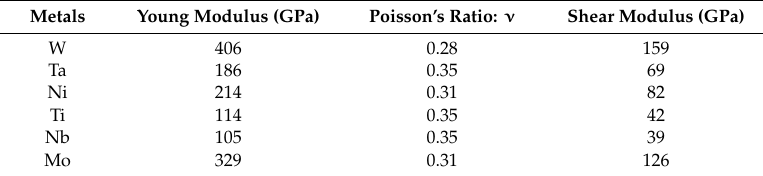
Table 4. The Young modulus, Poisson’s ratio, and shear modulus of all metals.